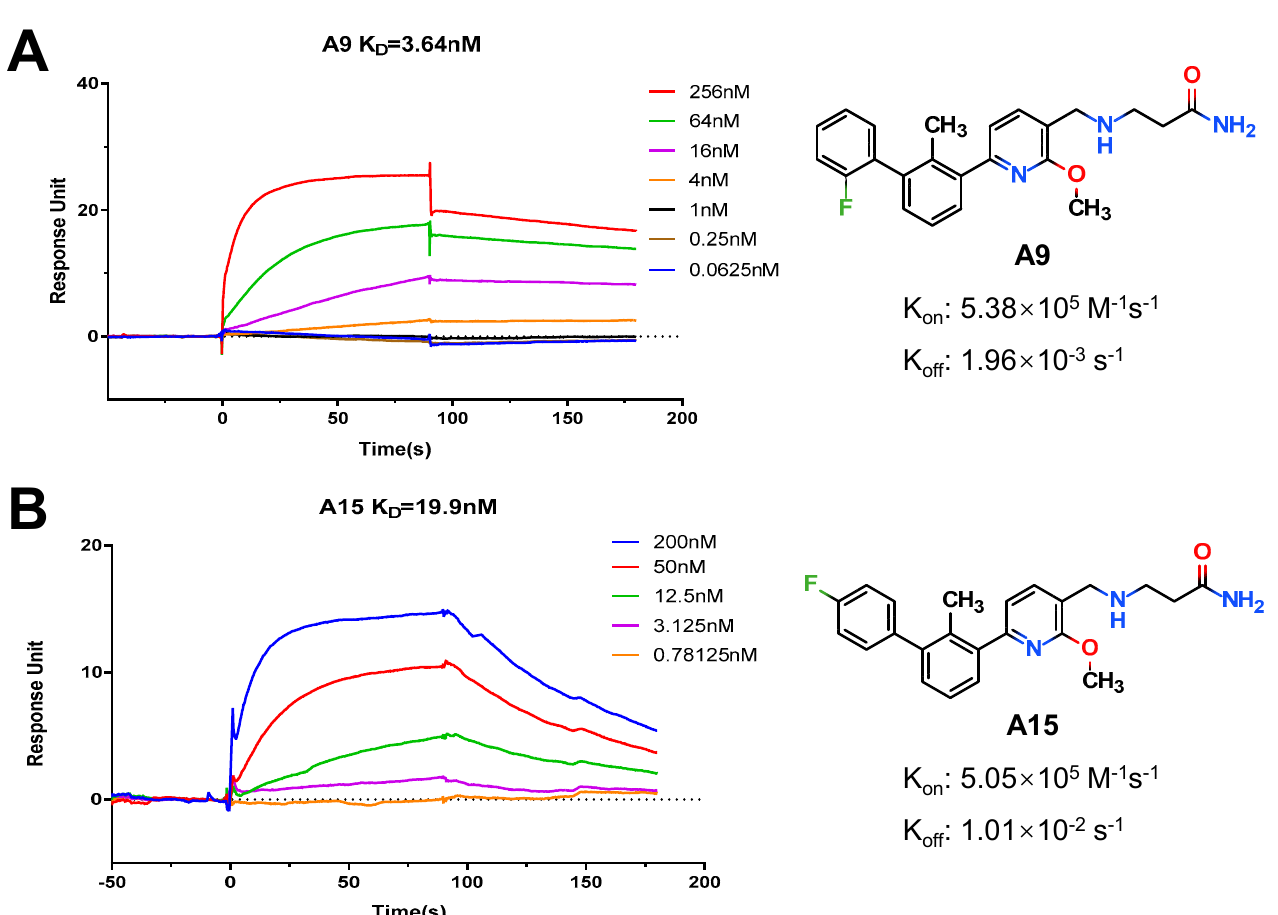
Figure 5. Association and dissociation kinetic curves of compounds A9 ( A ) and A15 ( B ) at different concentrations with hPD-L1.